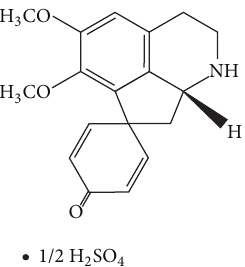
Figure 1: Structural chemical formula of stephaglabrine sulfate (image is adopted from PubChem Compound